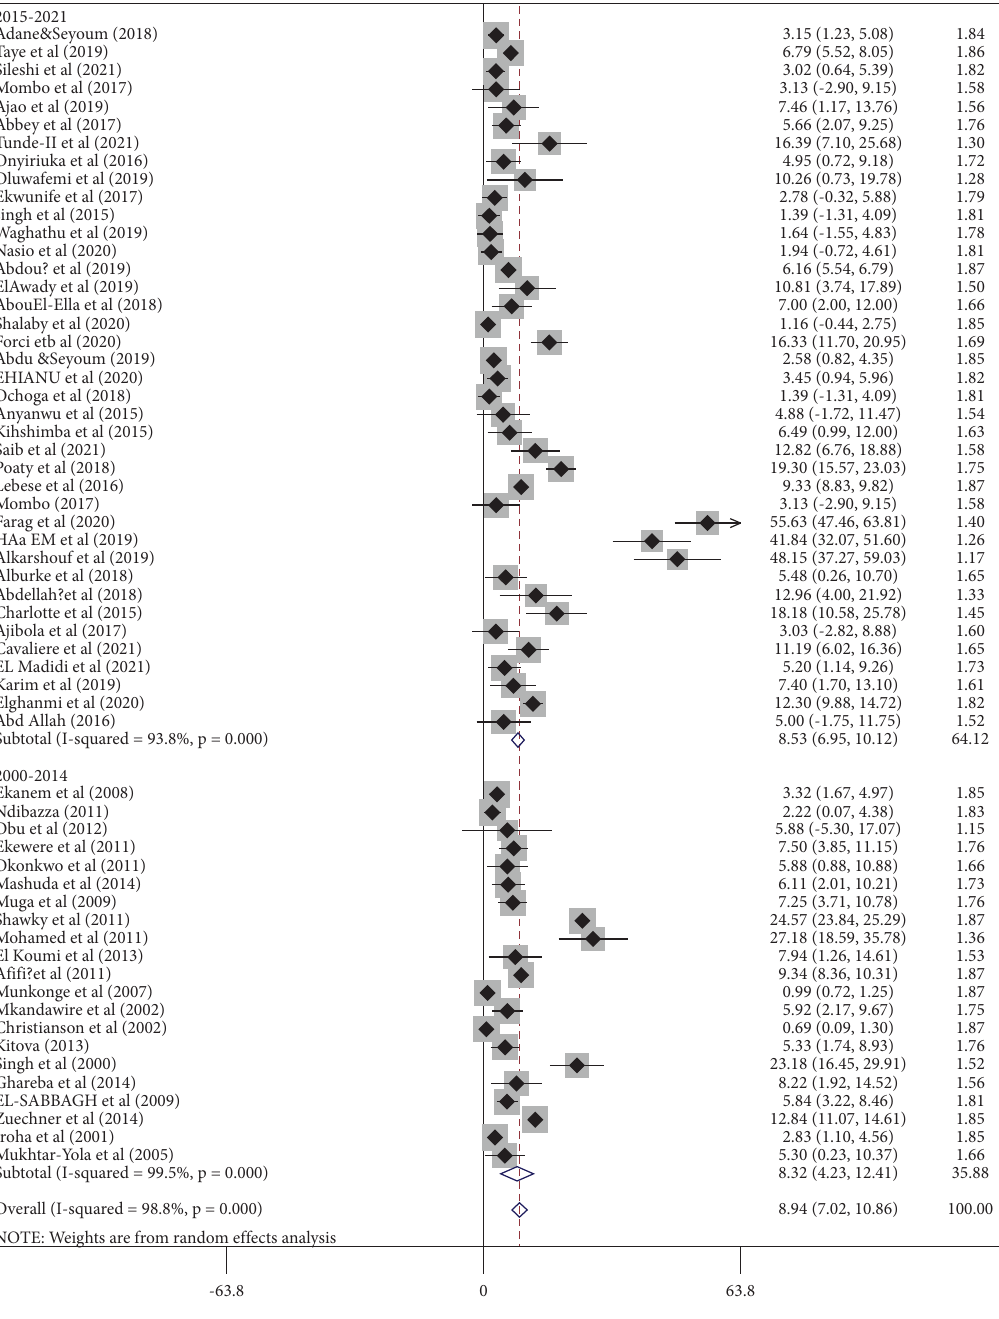
Figure 4: Forest plot on the pooled proportion of chromosomal disorders among births with congenital anomalies in Africa from January, 2000 to October,